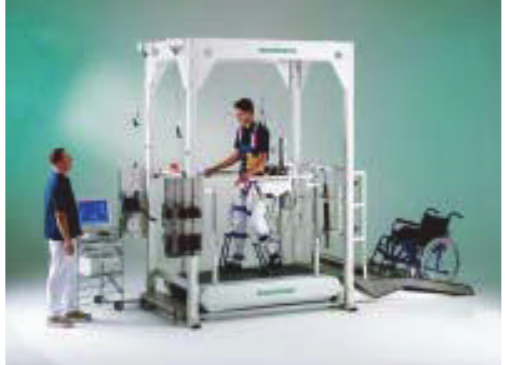
Figure 4: Lokomat.